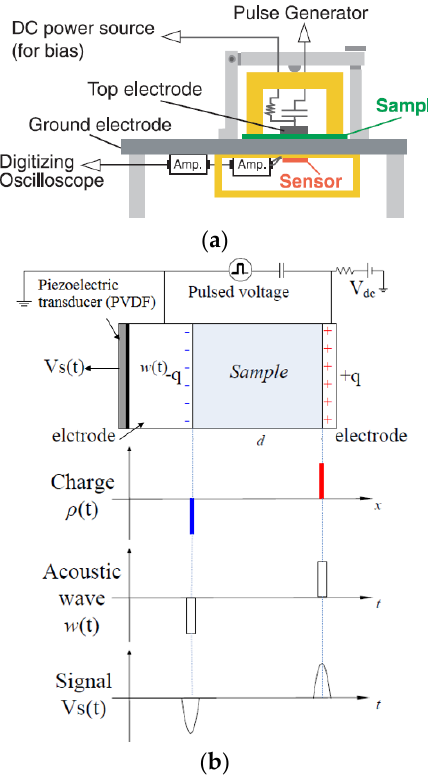
Figure 1. Basic set ‐ up ( a ) and schematic diagram ( b ) of PEA method. Figure 1. Basic set-up ( a ) and schematic diagram ( b ) of PEA